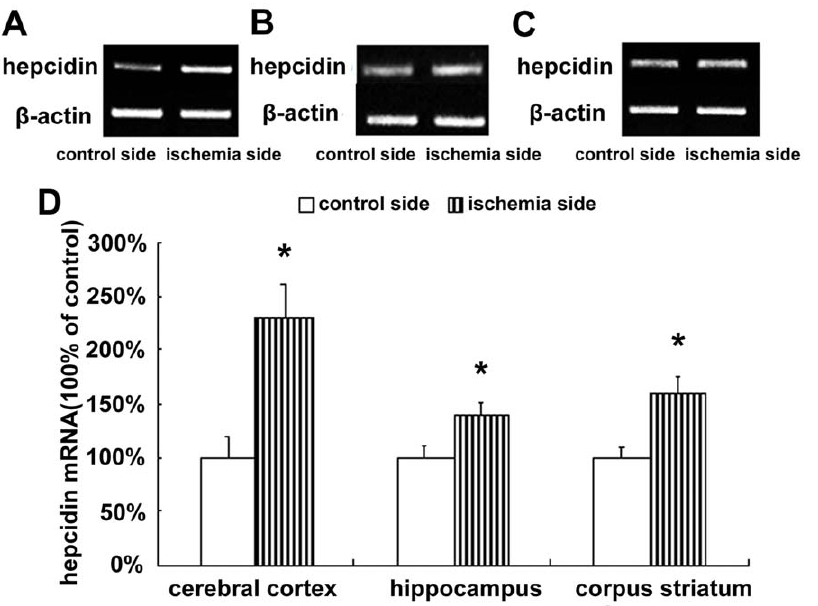
Figure 3. mRNA expression of hepcidin in ischemic brain. Rats were subjected to 60 min MCAO and 24 hour reperfusion. RT-PCR analyses were carried out to evaluate the mRNA level of hepcidin in the cerebral cortex (A), hippocampus (B) and corpus striatum (C) of contralateral and ipsilateral side. Fig. 3D shows the summary of hepcidin expression from three animals in each group. The expression of hepcidin was significantly increased in the ischemic cerebral cortex, hippocampus and corpus striatum at 24 h. Results are presented as Mean 6 SEM, n=3. *p , 0.05 v.s. contralateral side.